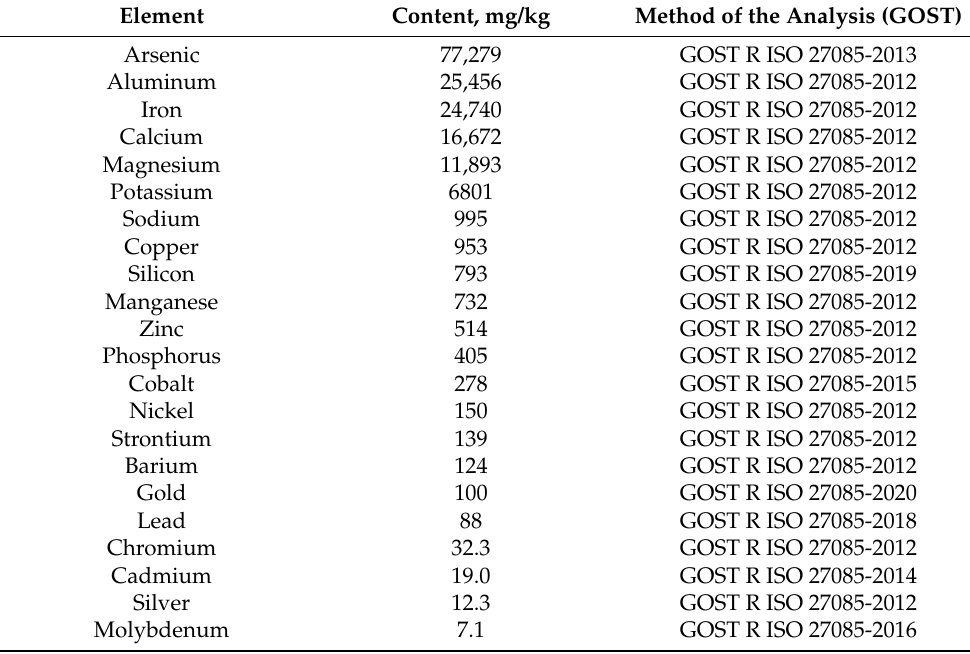
Table 1. Element content in arsenopyrite